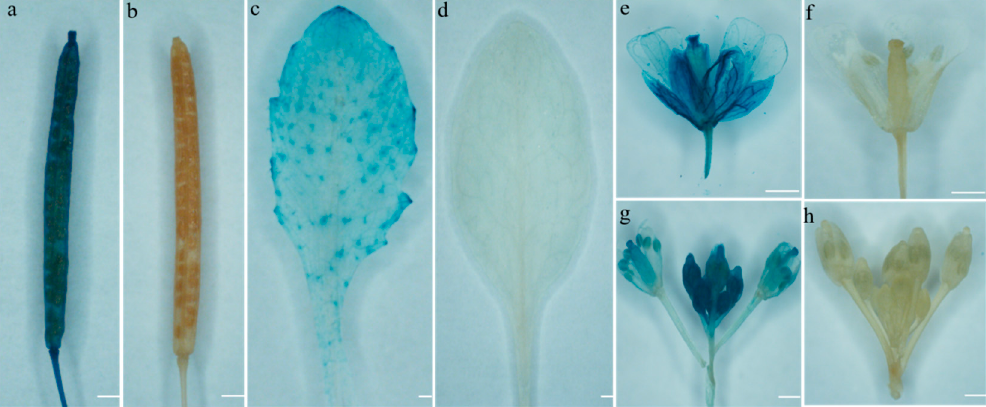
Figure 9. GUS staining diagram. Transgenic Arabidopsis was used as the experimental group and Columbia wild type Arabidopsis was the control group: ( a ) pods; ( c ) leaves; ( e ) flowers; ( g ) buds; ( b , d , f , h ) CK. Bar = 25 µm.